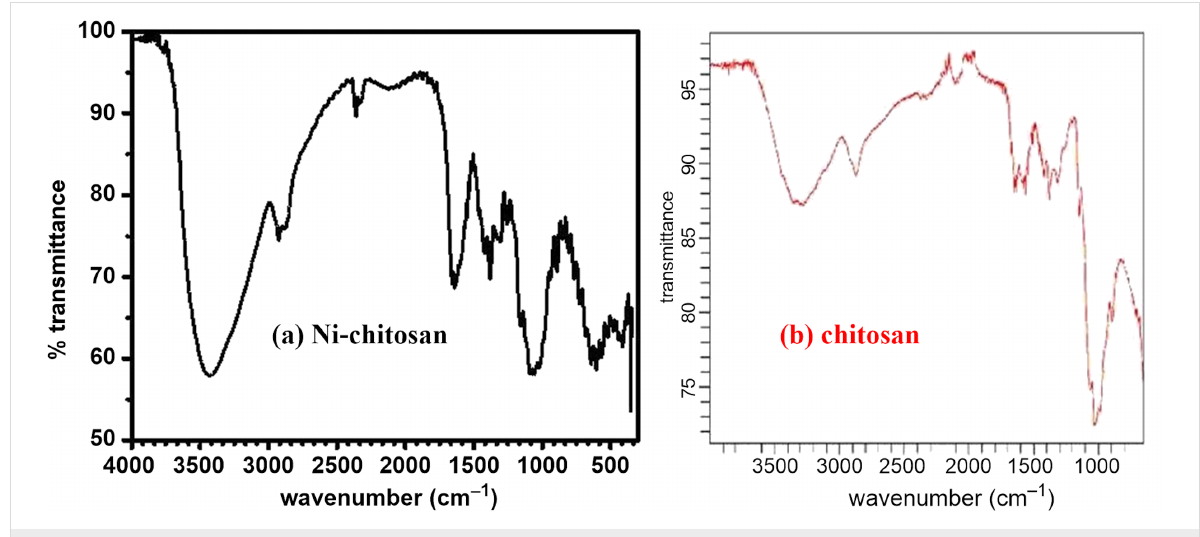
Figure 1: FTIR spectra of (a) the Ni–chitosan NPs and (b) bare chitosan.